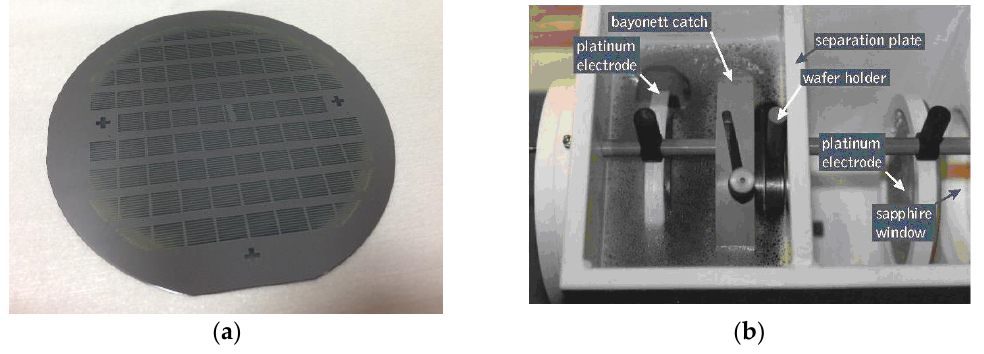
Figure 5. ( a ) Photography of a 3-in-diameter silicon wafer with processed porous silicon trenches; ( b ) Double cell HF tank for porous silicon etching with electrolytic backside contact (AMMT ™ ).